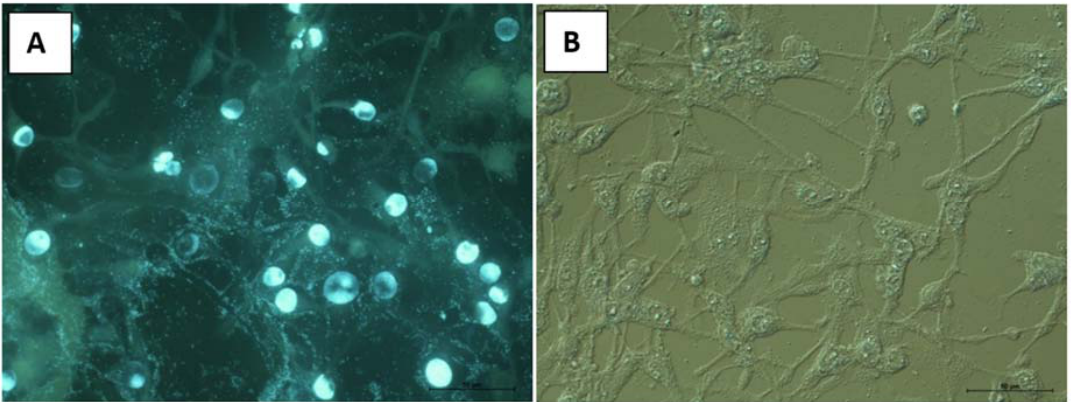
Figure 4. BHK-21 cell line stained with Hoechst after administration of substance EE at 50 µg/mL ( A ). No changes in this cell line, BHK cell line in Nomarski contrast. Control group ( B ).